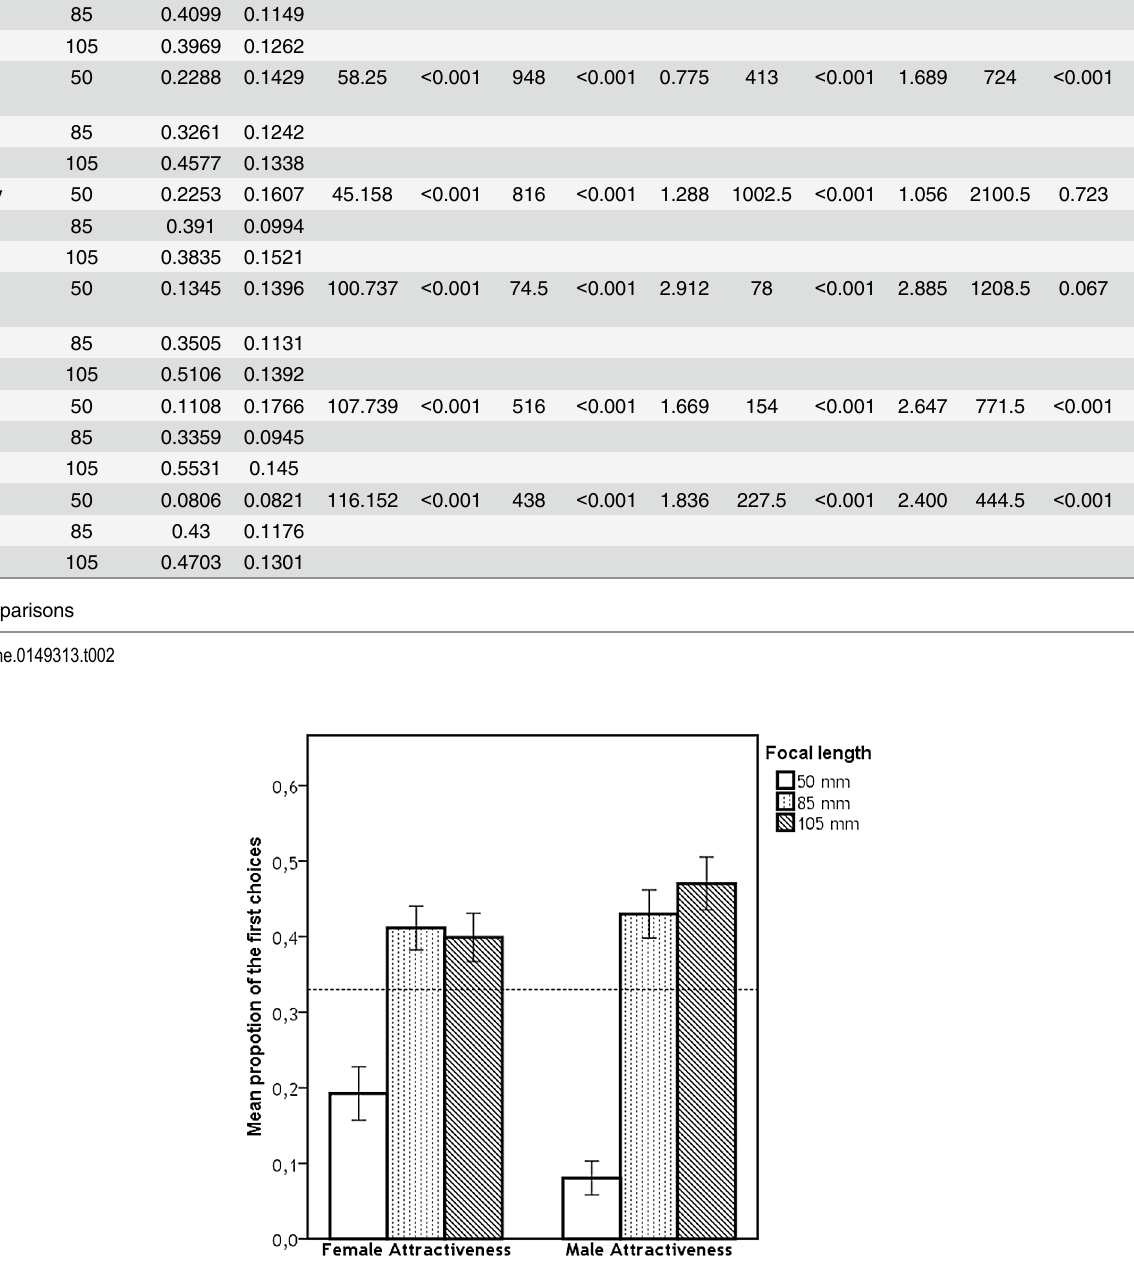
Fig 2. Proportion of first choices for each focal length with respect to their attractiveness. Dashed line represents the proportion of ratings expected by chance (i.e., 0.333), error bars represent 95%